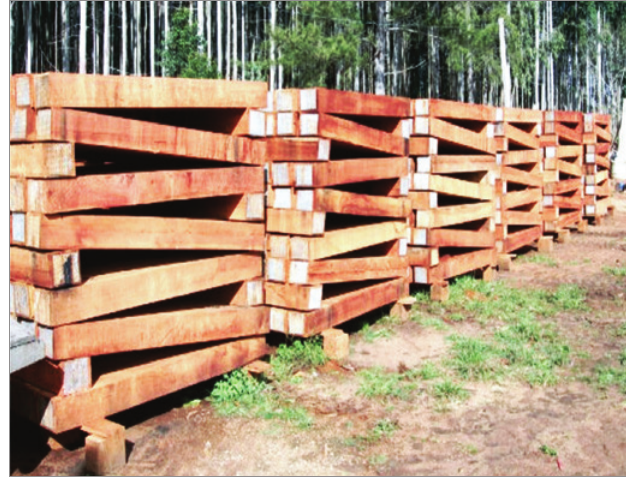
Most used railway gauge, Revista Ferroviária